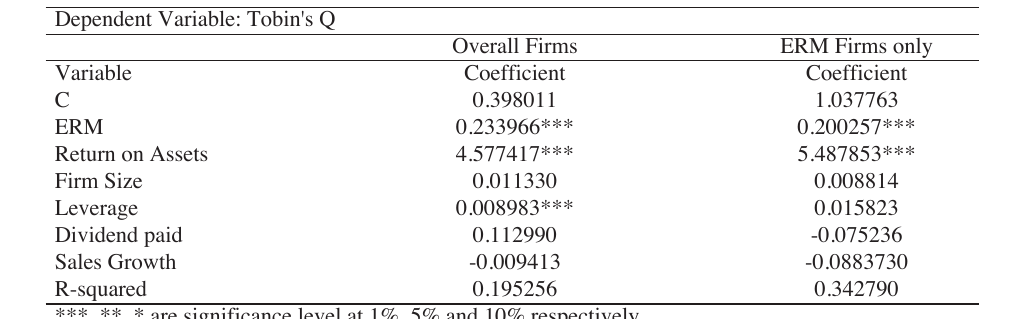
Relationship between ERM and Firm's Value